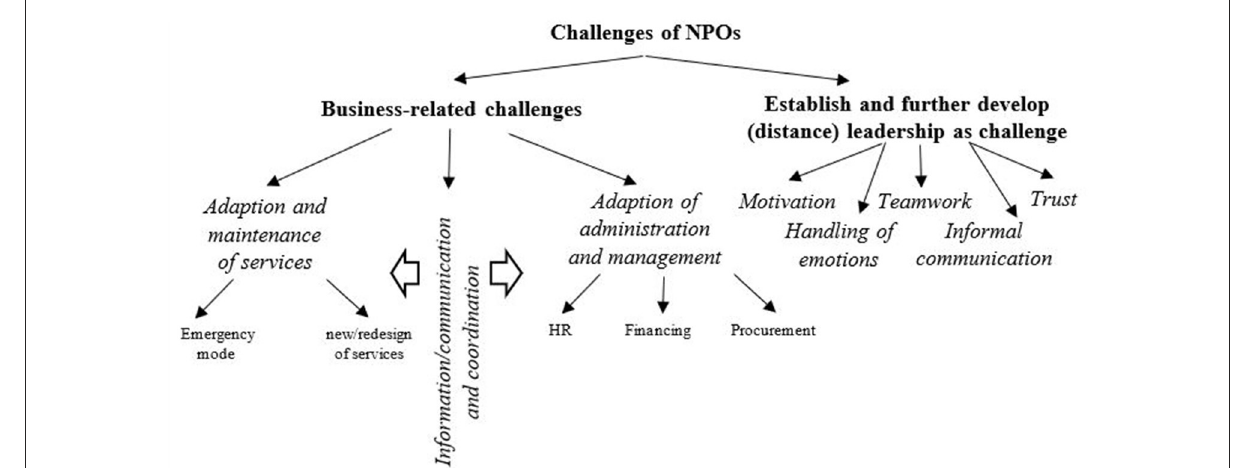
FIGURE2 Challenges of social and healthcare services NPOs in the COVID-19 pandemic.